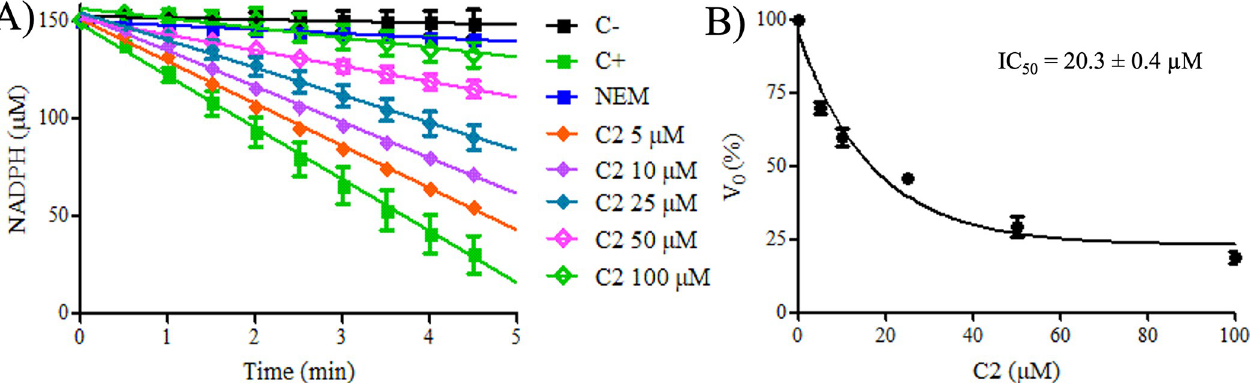
Fig 4. IC 50 determination of compound C2 for PaAhpC. (A) Aliquots of PaAhpC enzyme were reduced with 5 mM DTT for 1 hour and then desalted to remove excess of reductant. Aliquots containing 10 μ M of the reduced and desalted enzymes were treated varying the concentration of compound C2 (5, 10, 25, 50 and 100 μ M for 1 hour at room temperature and subsequently desalted again. Next, 3 μ M of the treated proteins were added to reactions containing 6 μ M EcTrx, 0.9 μ M EcTrxR, 150 μ M NADPH, 50 mM HEPES (pH 7.4), 100 μ M DTPA and 1 mM sodium azide. The reactions were incubated at 37˚C for 5 minutes before being initiated by the addition of 500 μ M H 2 O 2 and monitored spectrophotometrically at 340 nm, 37˚C, for 5 minutes. Reactions without treatment with compound C2 were used as positive controls (green square), and reactions without the addition of AhpC were used as negative controls (black square). (B) The initial rates ( v 0 ) of each reaction were calculated, transformed into percentual values, and plotted to calculate the IC 50 values of compound C2 for PaAhpC. All experiments were performed at least three times in triplicate.